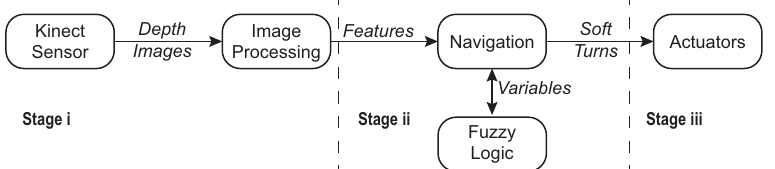
Figure 3. Architecture for the mobile robot based on fuzzy